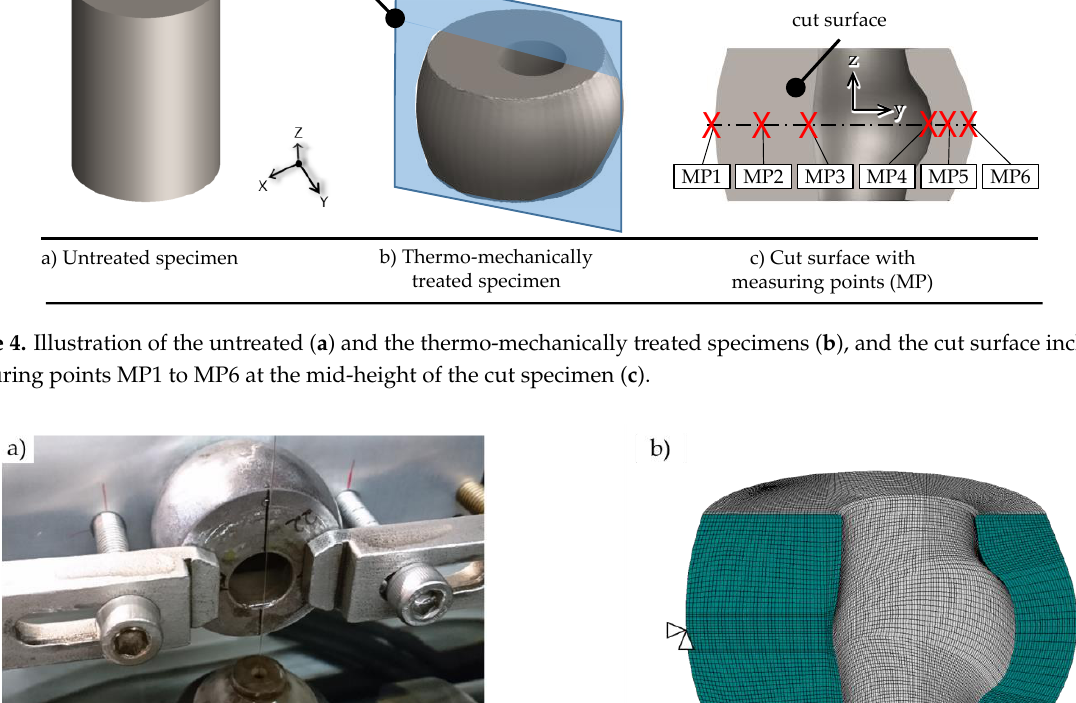
Figure 5. Application of the contour method for the analysis of the tangential RS component: ( a ) specimen clamping for WEDM and ( b ) FE model for RS evaluation.